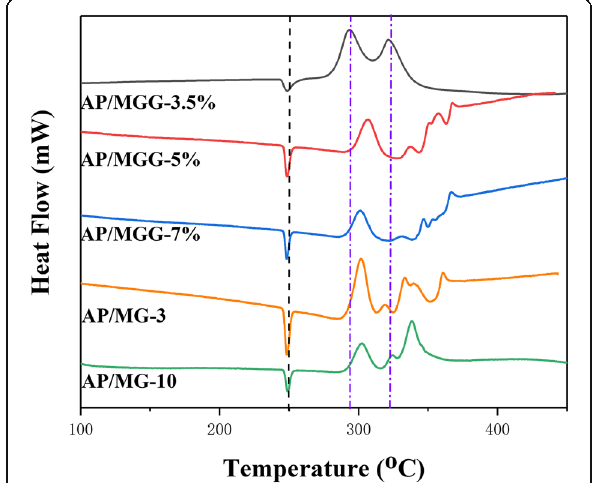
Fig. 12 DSC curves of different proportions of samples (10 °C/min, N 2